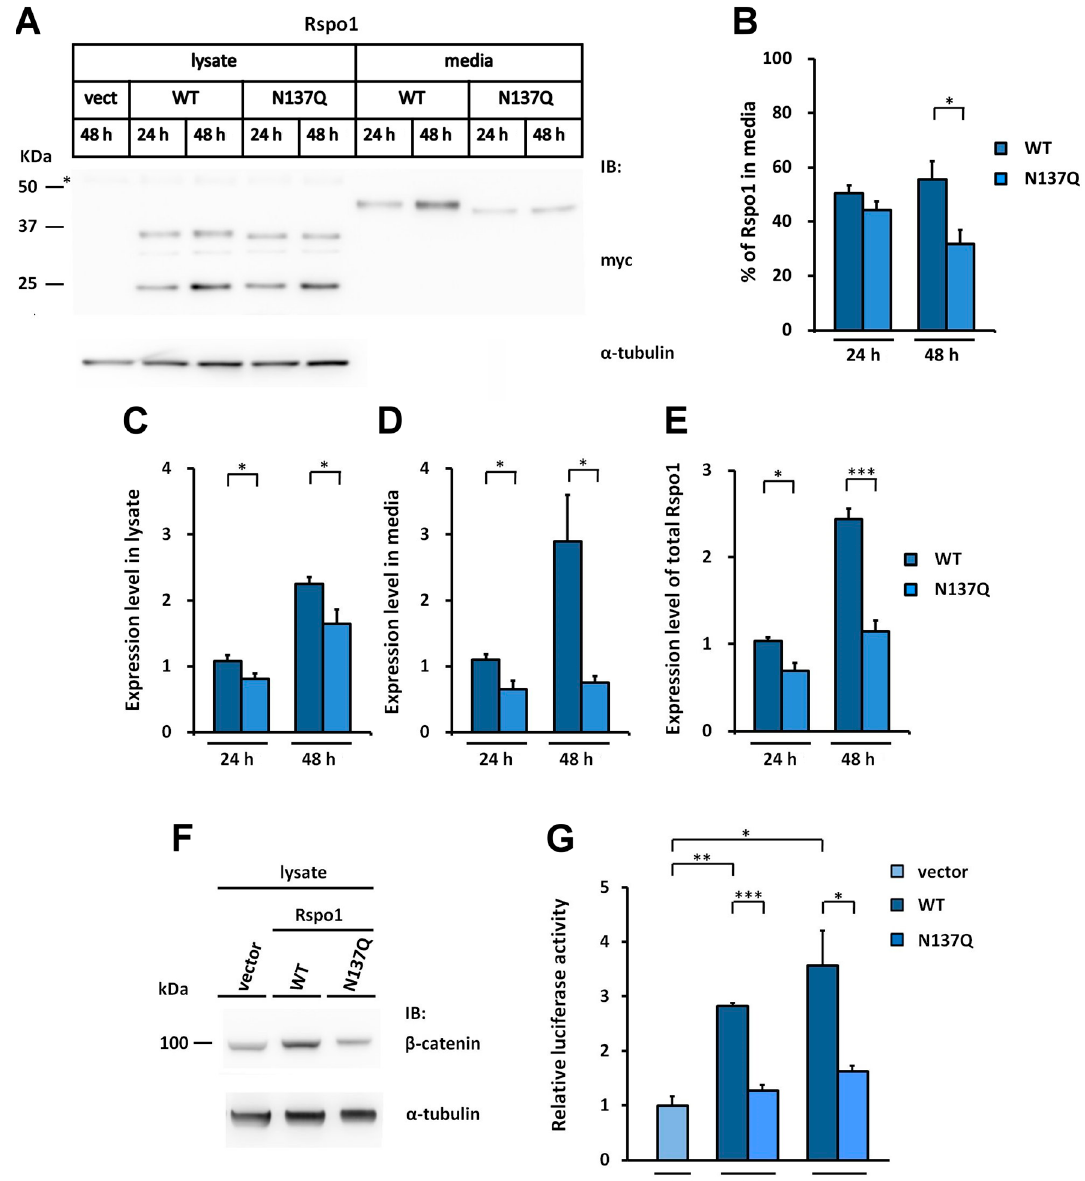
Figure 3. N-glycosylation of human Rspo1 enables efficient secretion from cells. ( A ) WT Rspo1 or N137Q mutant was transfected into HEK293T cells. After 24 or 48 h, the cell lysates and conditioned media were analyzed for myc-tagged Rspo1. Asterisk indicates non-specific bands; ( B – E ) Quantification of relative expression levels for human WT Rspo1 versus N137Q mutants in cell lysates, media and total. Immunoblots were quantified densitometrically and relative expression level of Rspo1 in media or lysate was calculated. Percentage of Rspo1 in media was defined as the Rspo1 in the media as a percentage of the total Rspo1 (lysates plus media). Error bars represent the mean ± SD; ( F ) WT Rspo1 or N137Q mutant was transfected into HEK293T cells. After 48 h, the cell lysates were analyzed for soluble β -catenin; ( G ) SuperTopFlash plasmids were co-transfected with the indicated amounts of control vector, WT or N137Q Rspo1-expressing plasmids. Renilla luciferase was included as a transfection control. Error bars represent the mean ± SD. All experiments were performed at least two times, in triplicate. The Student’s t -test was used to evaluate statistical significance (* p < 0.05; ** p < 0.01; *** p < 0.001). α -tubulin was used as a loading control for the cell lysates.